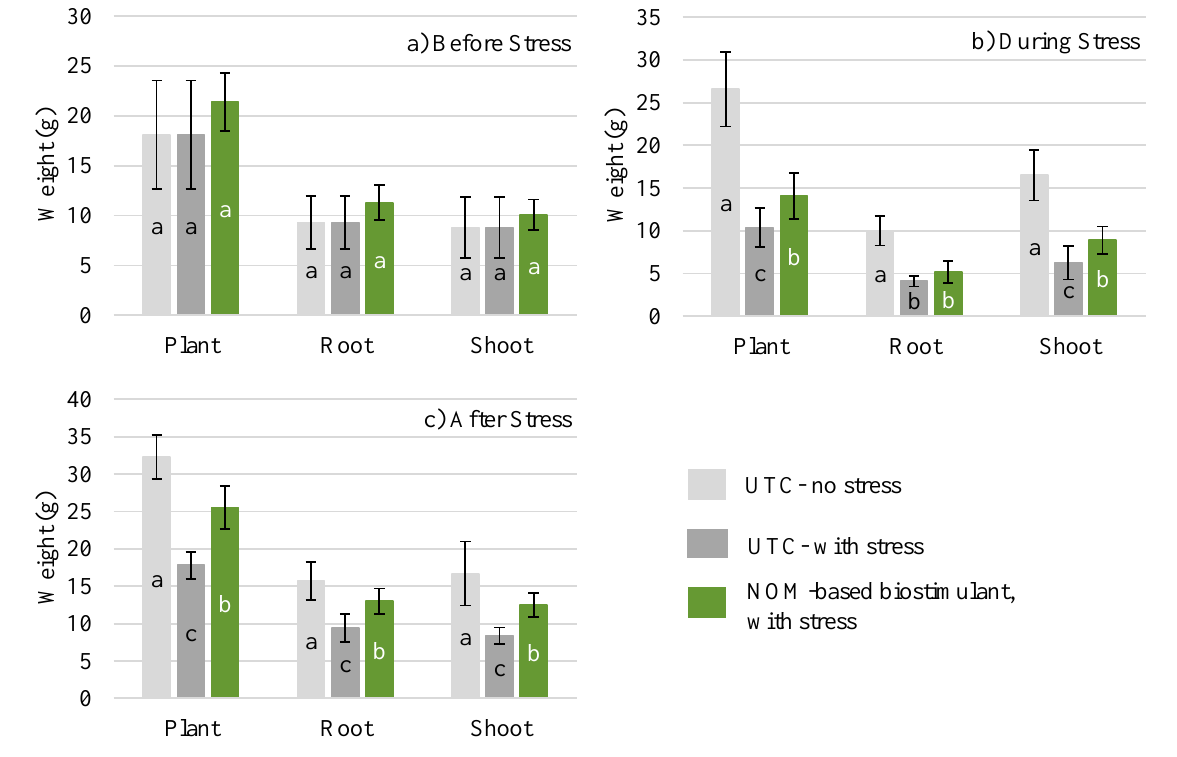
Figure 1. Average plant, root, and shoot weights before ( a ), during ( b ), and after ( c ) drought stress during the tomato nursery trial for the untreated check (UTC) non-stressed plants, UTC stressed plants, and NOM-based biostimulant treated stressed plants. Means with the same letter designation centered on each bar do not differ significantly ( p = 0.10, least significant difference), and error bars represent one standard deviation. See also Supplementary Table S1, where ANOVA p values are reported.